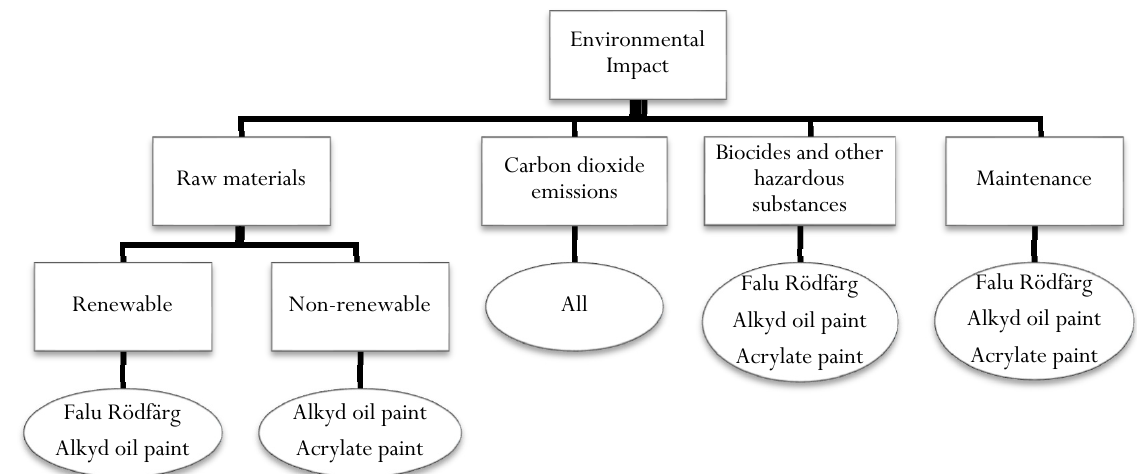
Figure 3. Overview of environmental impact of surface treatments during manufacture and use.